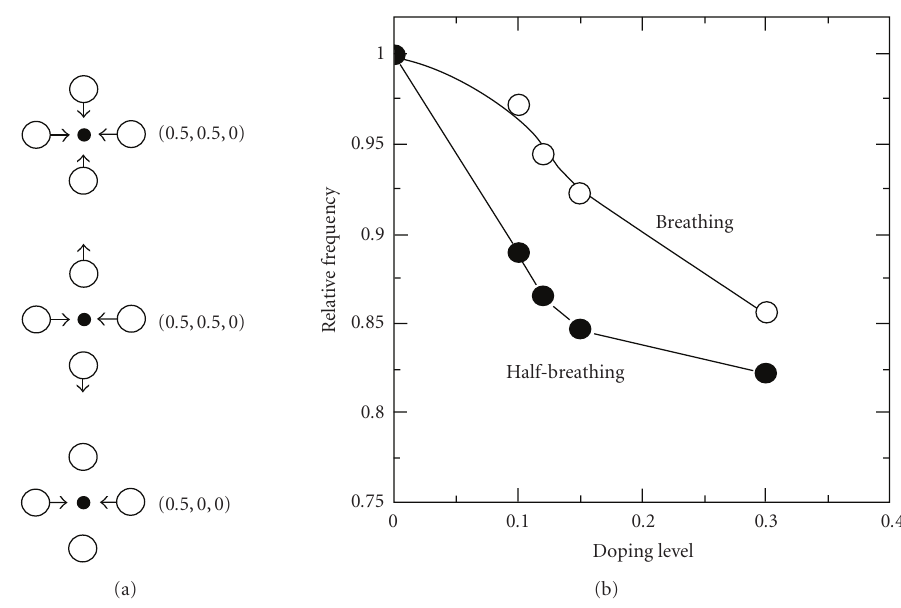
Figure 7: (a) Displacement patterns of zone-boundary bond-stretching modes in cuprates. Top: longitudinal mode in the [110] direction (breathing mode); middle: transverse mode in the [110]-direction (quadrupolar mode); bottom: longitudinal mode in the [100] direction (half-breathing mode). Circles and full points represent oxygen and copper atoms, respectively. Only the displacements in the Cu–O planes are shown. All other displacements are small for these modes. (b) Schematic of the doping dependence of the breathing q = (0 . 5,0 . 5,0) and half-breathing q = (0 . 5,0,0) zone boundary mode frequencies. This behavior is probably not directly related to the mechanism of superconductivity, since the softening continues into the overdoped nonsuperconducting part of the phase diagram from